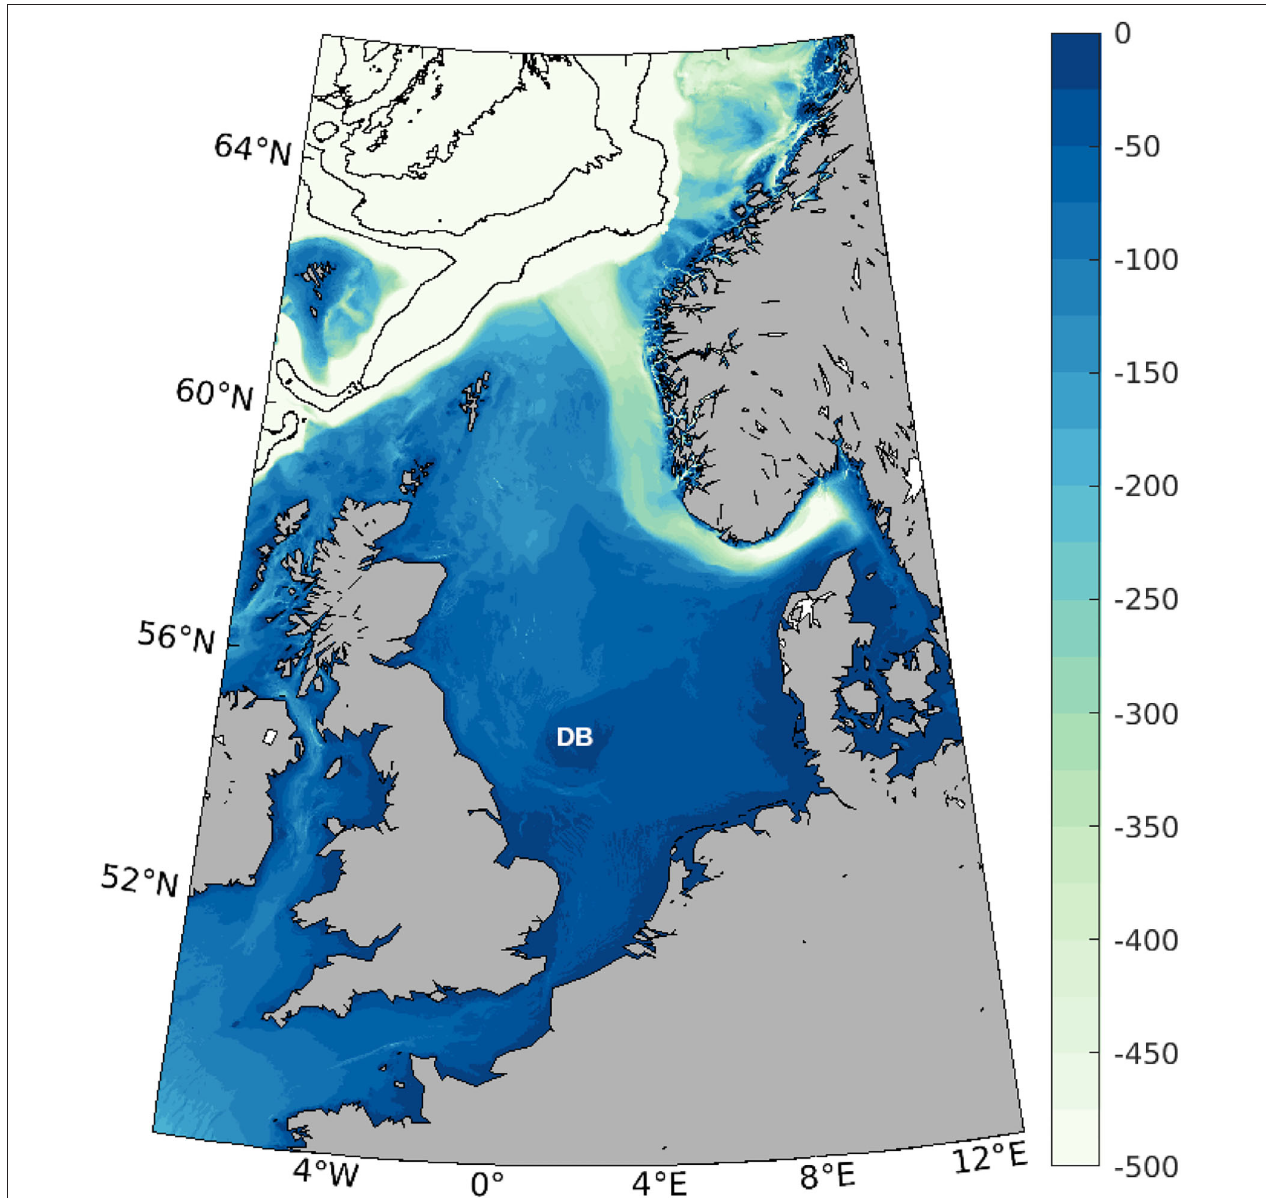
FIGURE 1 | Domain of study with bathymetry (in m). The contours in the northwest part of the domain correspond to the 1,000, 2,000, and 3,000 m depth. DB shows the location of the Dogger